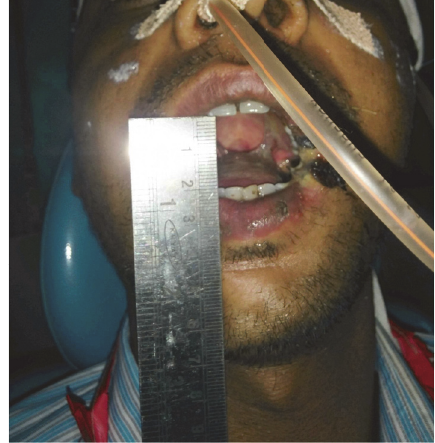
Figure 6: 3rd postoperative day immediately after assisted mouth opening—21 mm.